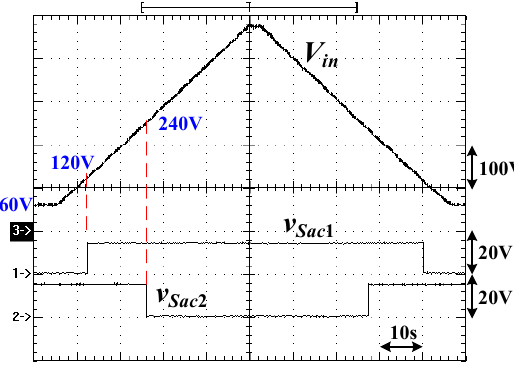
Figure 7. Measured waveforms of V in , S ac 1 , and S ac 2 .